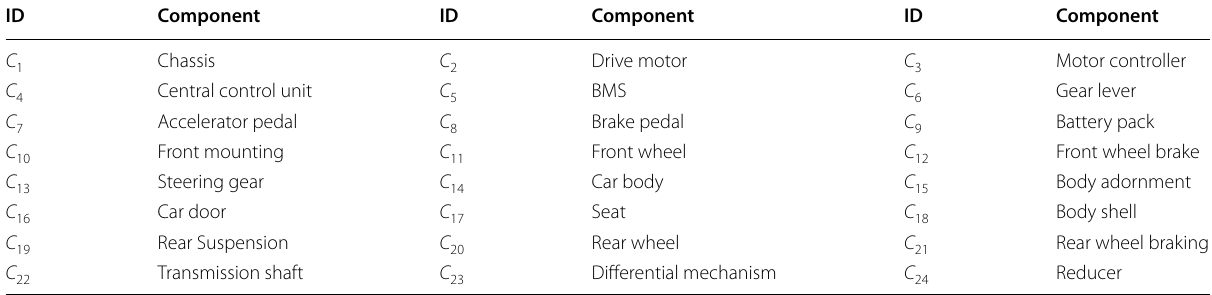
Table 5 Components of an EV